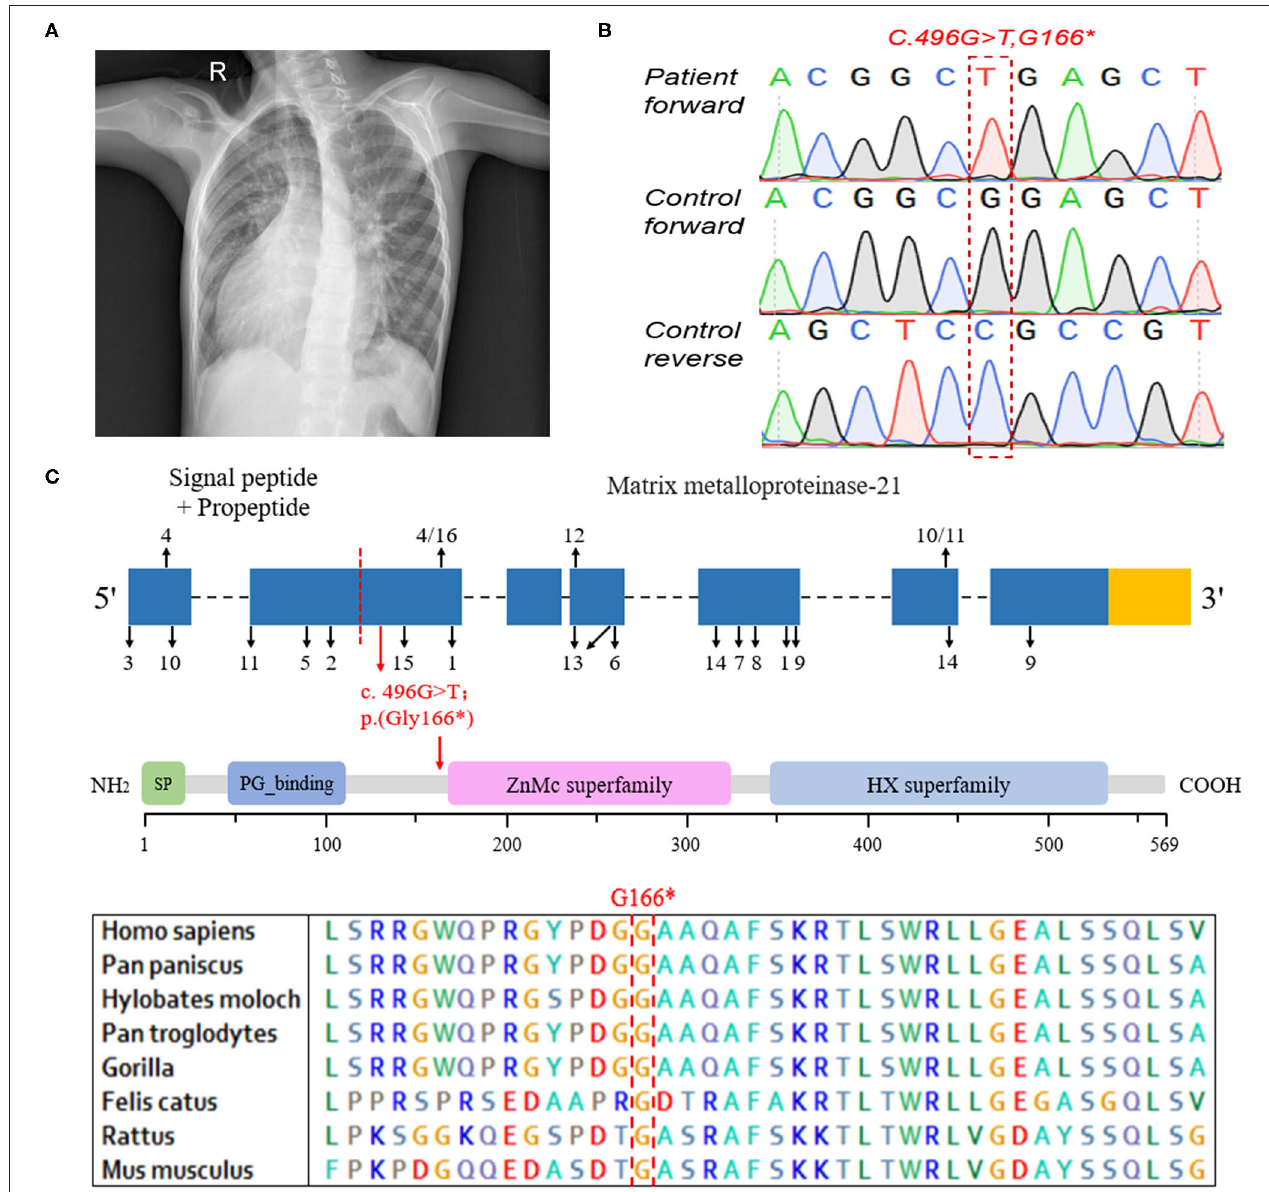
FIGURE 1 | The clinical data and genetic analysis of the patient with MMP21 variant. (A) Chest X-ray of the patient indicating dextrocardia. (B) Sanger DNA sequencing chromatogram demonstrating the homozygosity for an MMP21 stopgain variant (c.G496T; p.G166*). (C) The sequence encoding the signal peptide and propeptide is before the red dotted line, the subsequent sequence encodes matrix metalloproteinase-21, the red arrow indicates the variant identified in this study, and the numbers and black arrows indicate the family in Table 2 and position of MMP21 variants, respectively. Domain structure of MMP21. SP, signal peptide; PG_binding, putative peptidoglycan-binding domain; ZnMc superfamily, zinc-dependent metalloprotease; HX superfamily, hemopexin-like